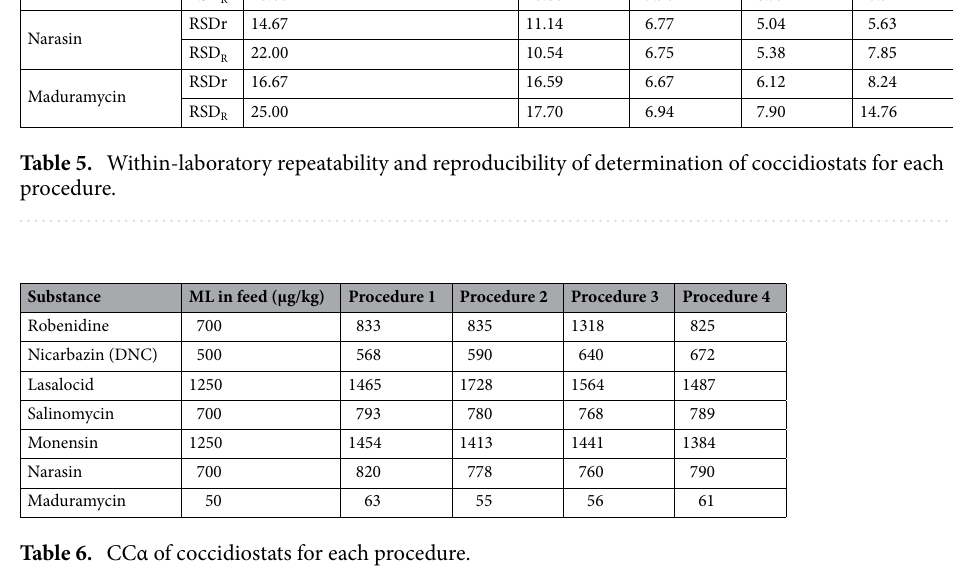
Table 6. CCα of coccidiostats for each procedure.